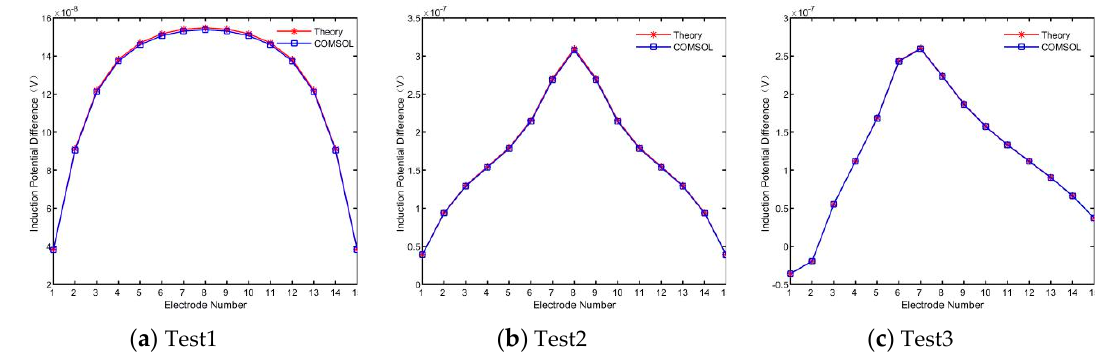
Figure 8. The difference of potential in different test conditions.